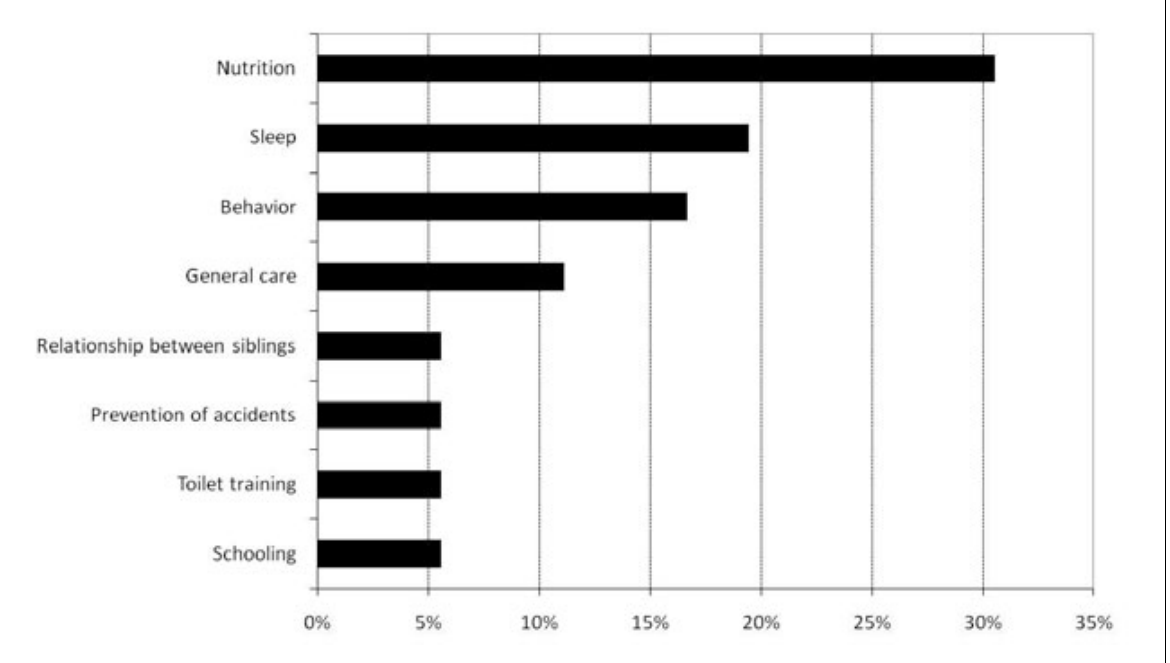
Figure 3. Themes about which mothers most commonly seek advice (according to pediatricians).